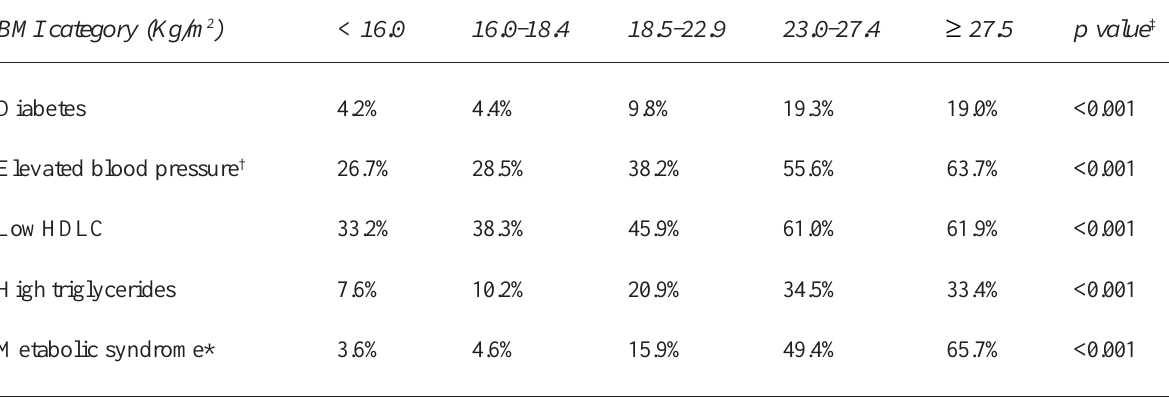
Table 1. Prevalence of diabetes, elevated blood pressure, hypertriglyceridaemia, low